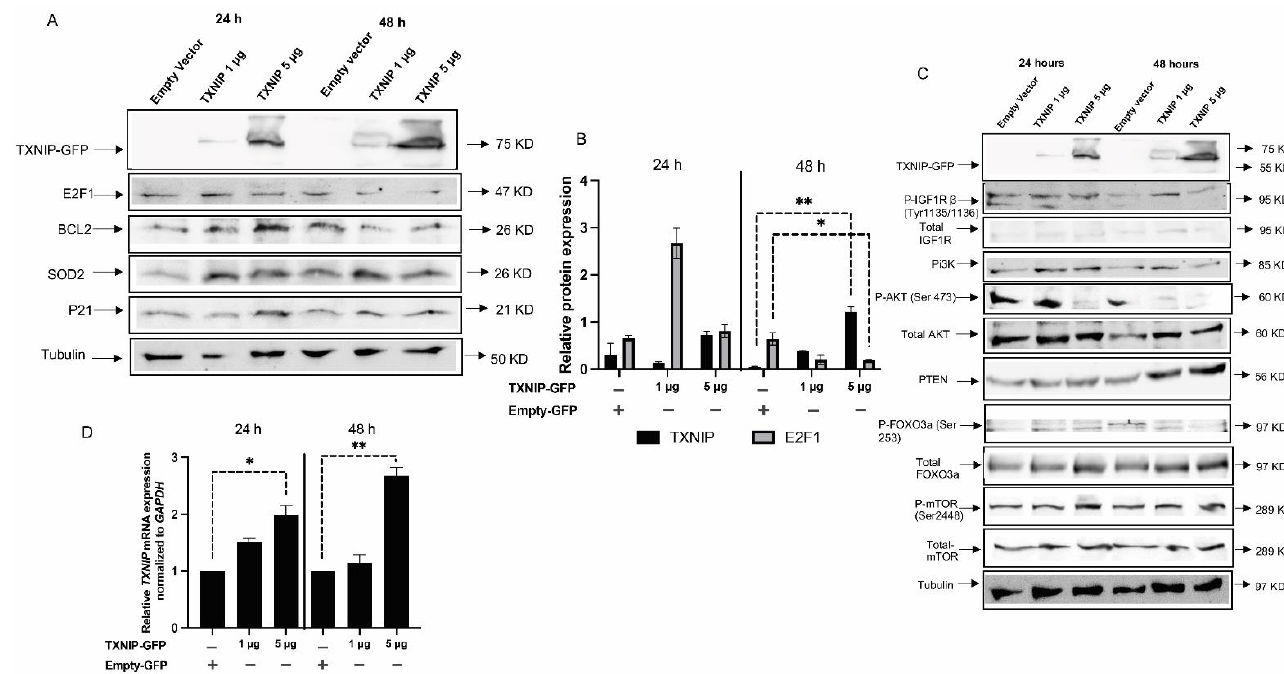
Figure 3. Effect of ectopic TXNIP overexpression in TXNIP-KD HEK293t cells. ( A ) TXNIP-KD HEK293t cells were transfected with 1 or 5 μ g of a TXNIP-GFP expression vector (or empty plasmid) for 24 or 48 h. Cells were then harvested and levels of E2F1, BCL2, SOD2, P21 and tubulin were measured by Western blots. ( B ) Scanning densitometry analysis of TXNIP, SOD2 and E2F1 levels, as shown in panel A. ( C ) Western blot analysis of IGF1R/PI3K/AKT signaling mediators in TXNIP- GFP transfected cells. ( D ) RT-QPCR analysis of TXNIP mRNA levels in TXNIP-GFP-transfected cells. Values are normalized to the GAPDH housekeeping gene. Bars represent mean ± SEM of three independent experiments. A value of 1 was given to the mRNA levels in untreated cells. * p - value ≤ 0.05; ** p - value ≤ 0.01.